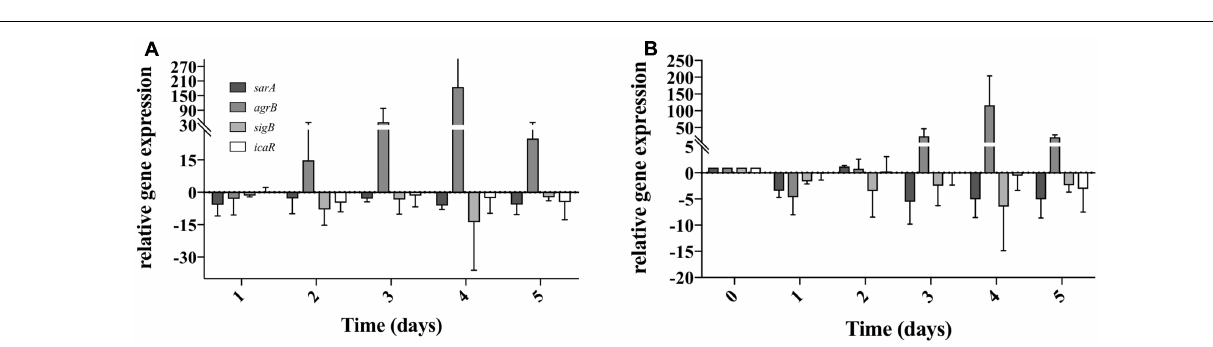
Frontiers in Microbiology |